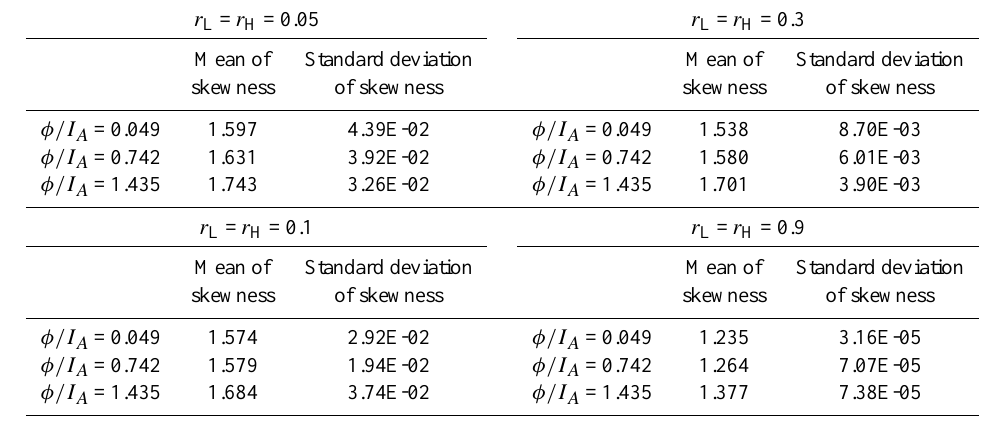
Table 10. Mean and standard deviation of skewness for different values of r L = r H ; A ranges from 10 to 500km 2 and I 1 ranges from 10 to 50mmh − 1 .